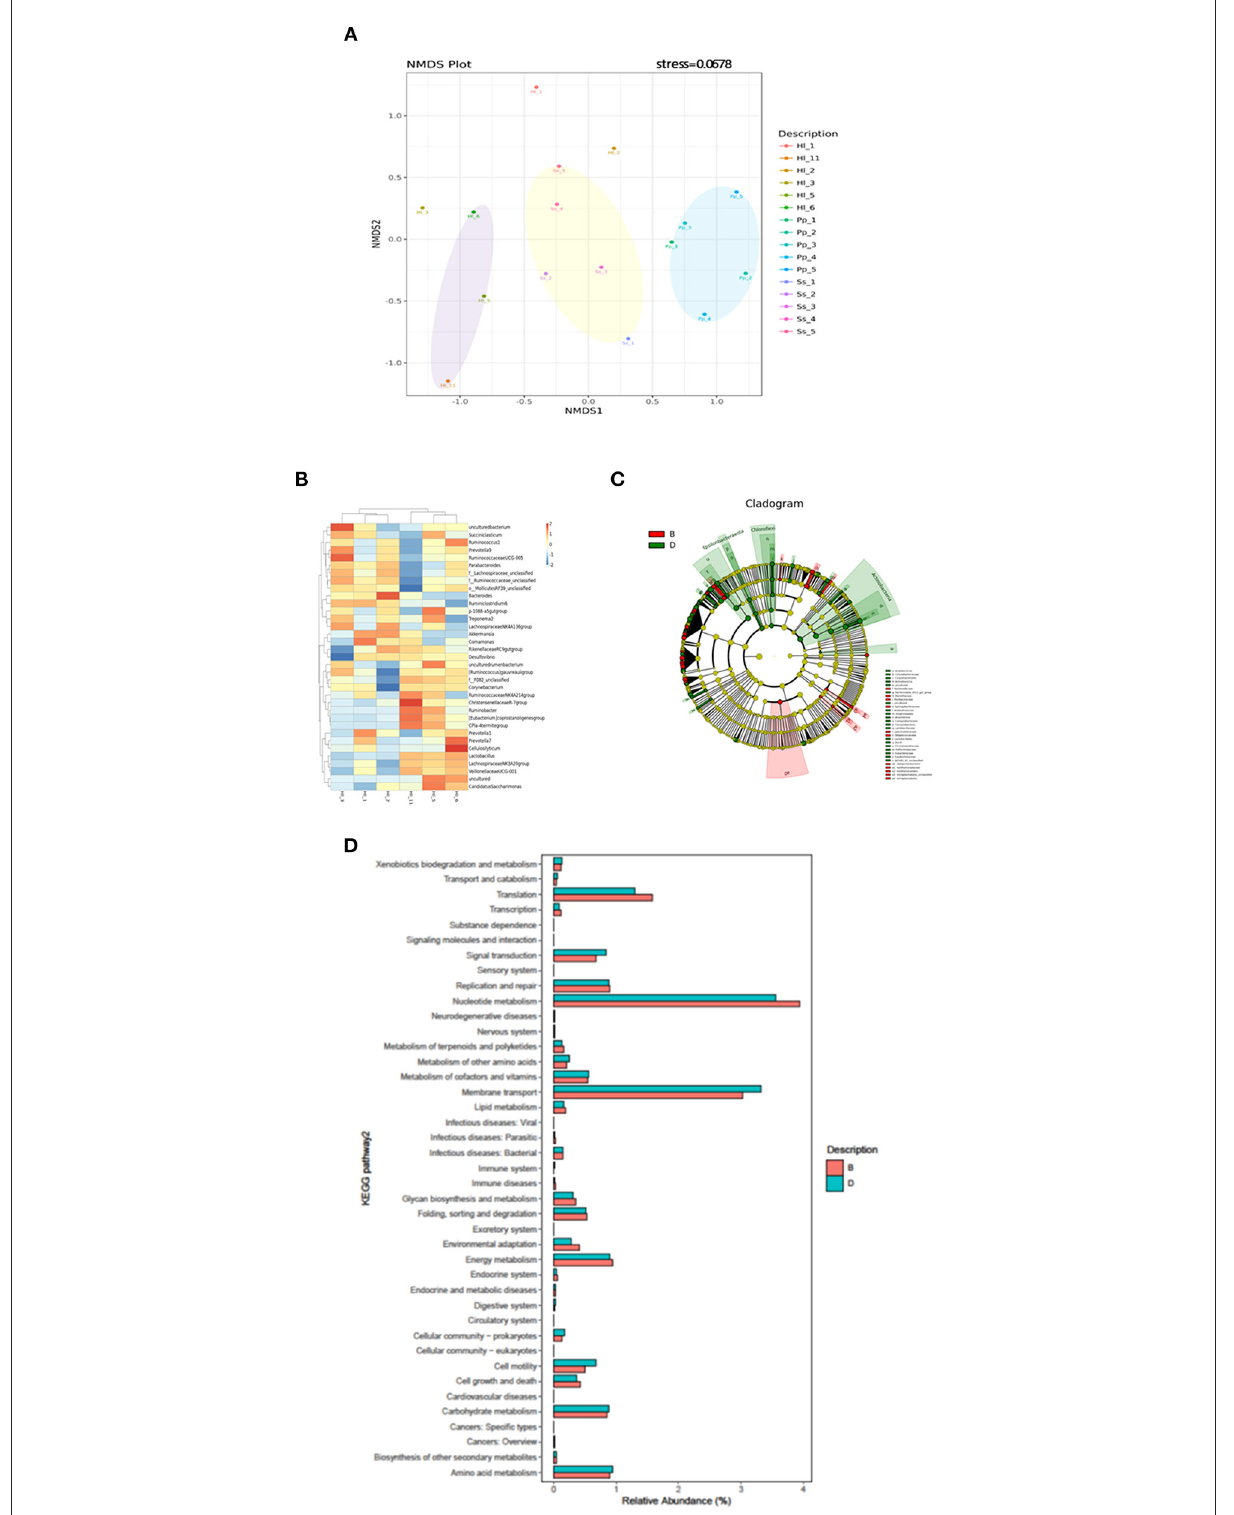
FIGURE3 Beta-diversity analysis of fecal microbiomes of white-handed gibbons (Hl), Bornean orangutans (Pp), and siamangs (Ss). The diversity of the samples was analyzed by (A) non-metric multidimensional scaling (NMDS) plot of Hl ( n = 6), Pp ( n = 5), and Ss ( n = 5). (B) Heatmap analysis at the genus taxa level. The top 35 genera of Hl housed in the rainforest area (Hl1, Hl2, and Hl3) and the conservation area (Hl5, Hl6, and Hl11) were compared. (C) LEfSe analysis for identification of index taxa between Hl inhabiting the rainforest area ( n = 3) and those in the conservation area ( n = 3). (D) Tax4Fun prediction of KEGG metabolic pathways of the gut microbiota in Hl inhabiting the Asian tropical rainforest area or the conservation area ( n = 3 for each area). (B) Asian tropical rainforest area; (D) conservation